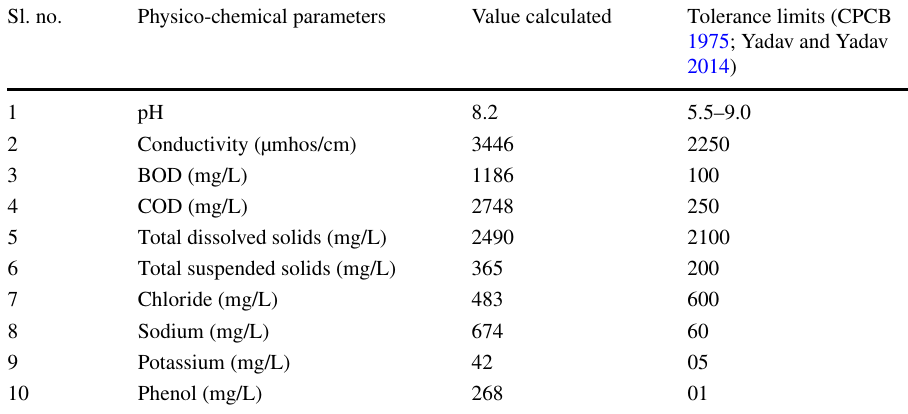
Table 1 Physico-chemical analysis of pulp and paper mill effluents